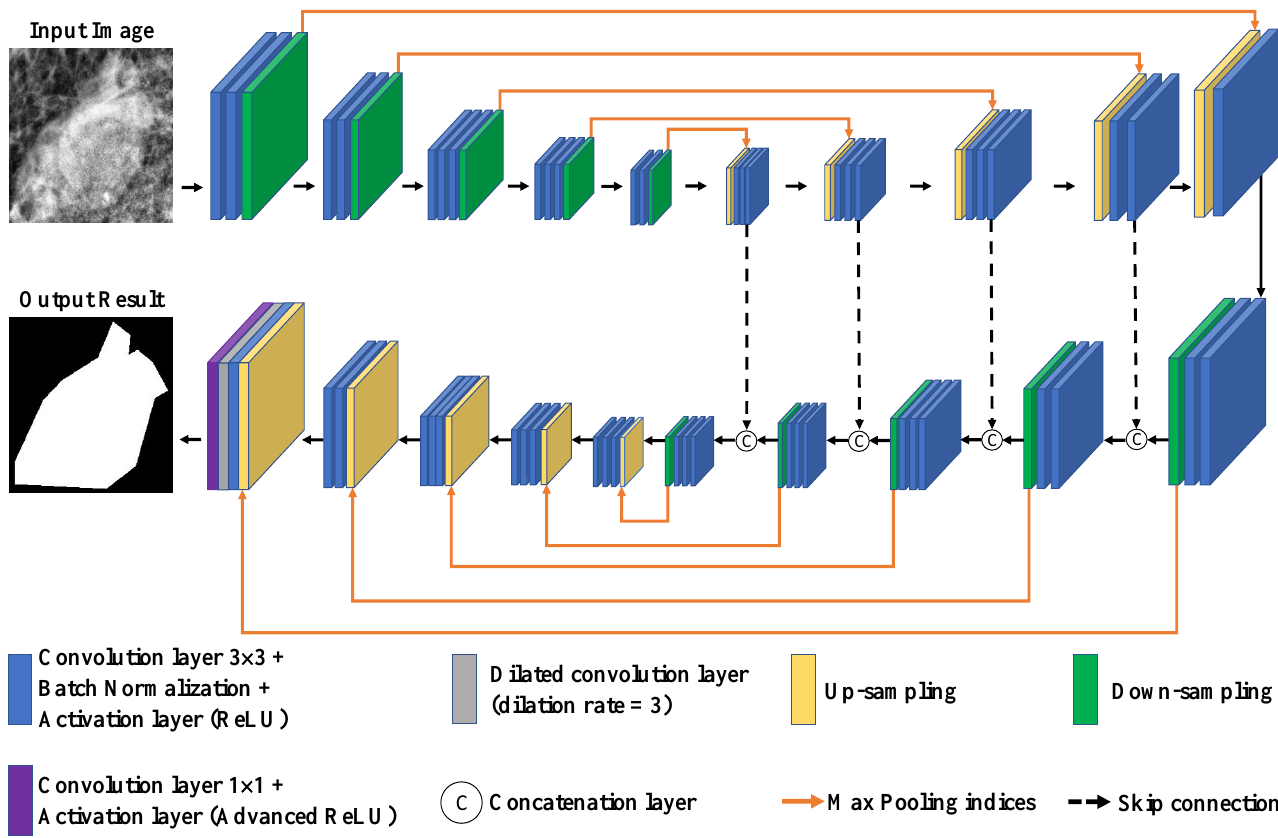
Figure 4. Architecture of the proposed Connected-SegNets